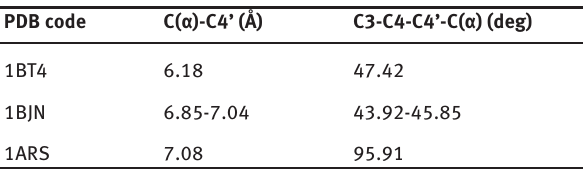
Table 5 : Factors that determine the torsion angle of the PLP-Lys aldimine. Column PDB refers to Protein Data Bank accession code: 1BT4, PSAT-BCIRA dimer; 1BJN, PSAT-ECOLI dimer; and 1ARS, AspAT dimer of E.coli